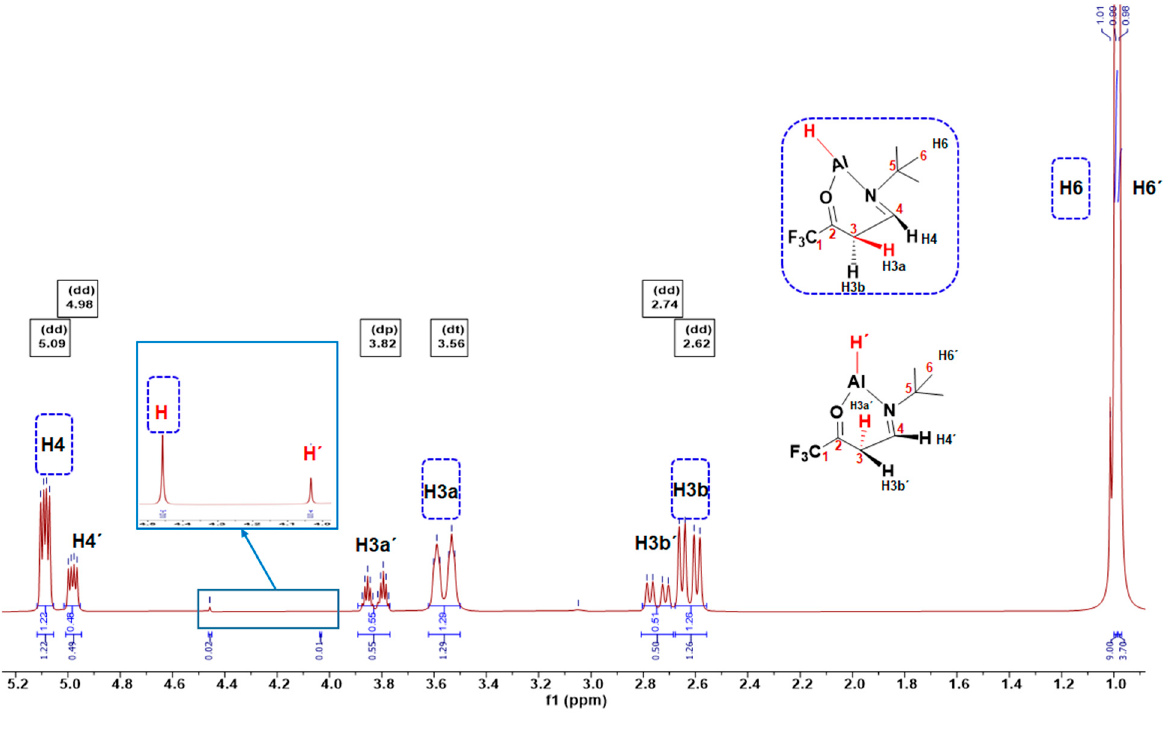
Figure 1. 1 H NMR spectra 4b and 4b ′ recorded in C 6 D 6 . Inset shows a magnified portion of the spectrum to illustrate the signal due to hydride ligands attached to the aluminium centre.